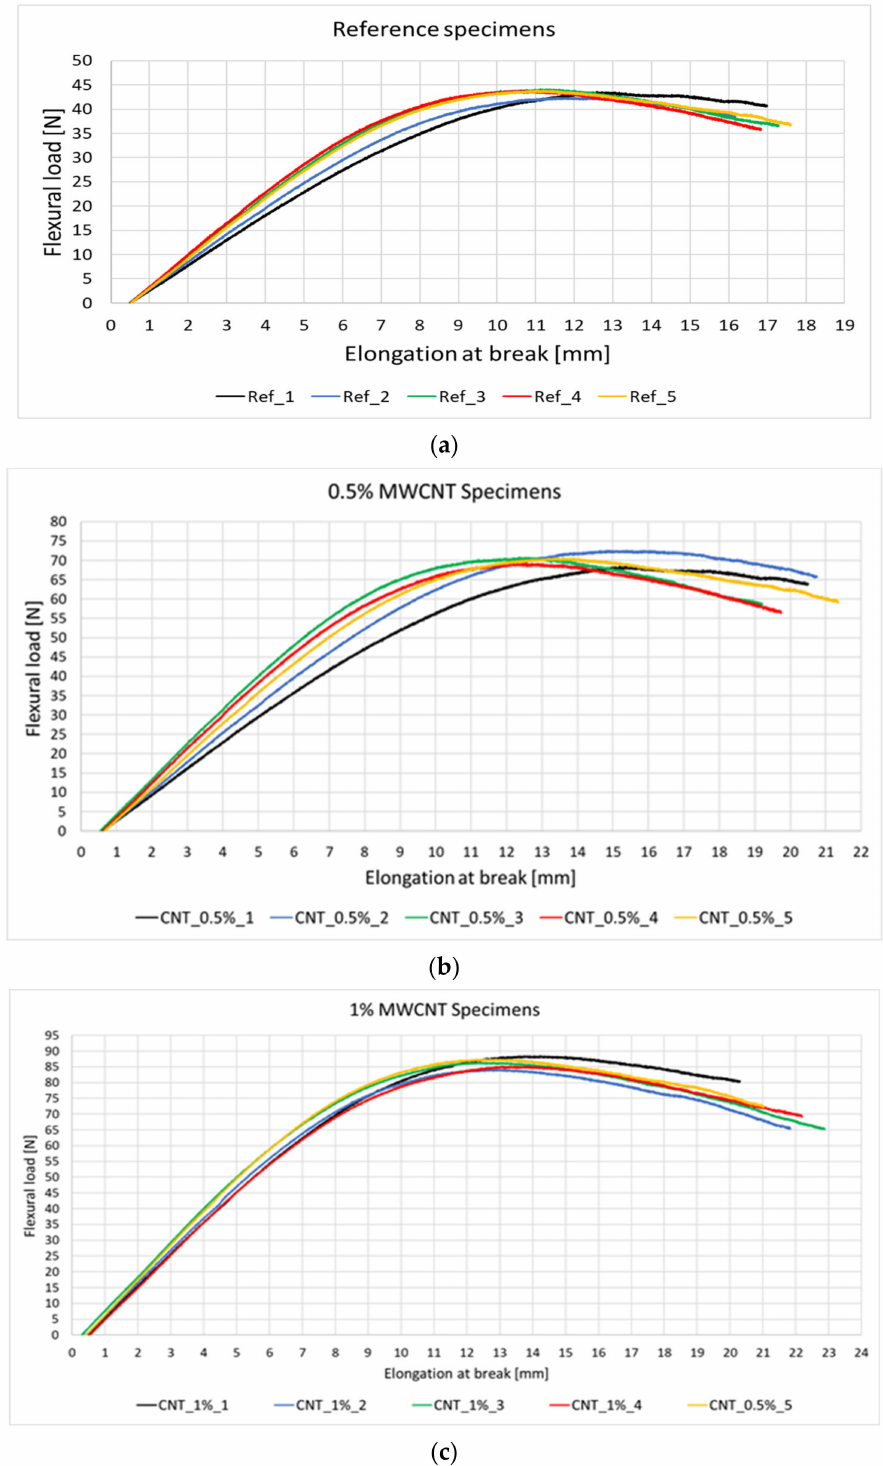
Figure 10. Flexural test results for the ( a ) reference, ( b ) 0.5%, and ( c ) 1% MWCNTs